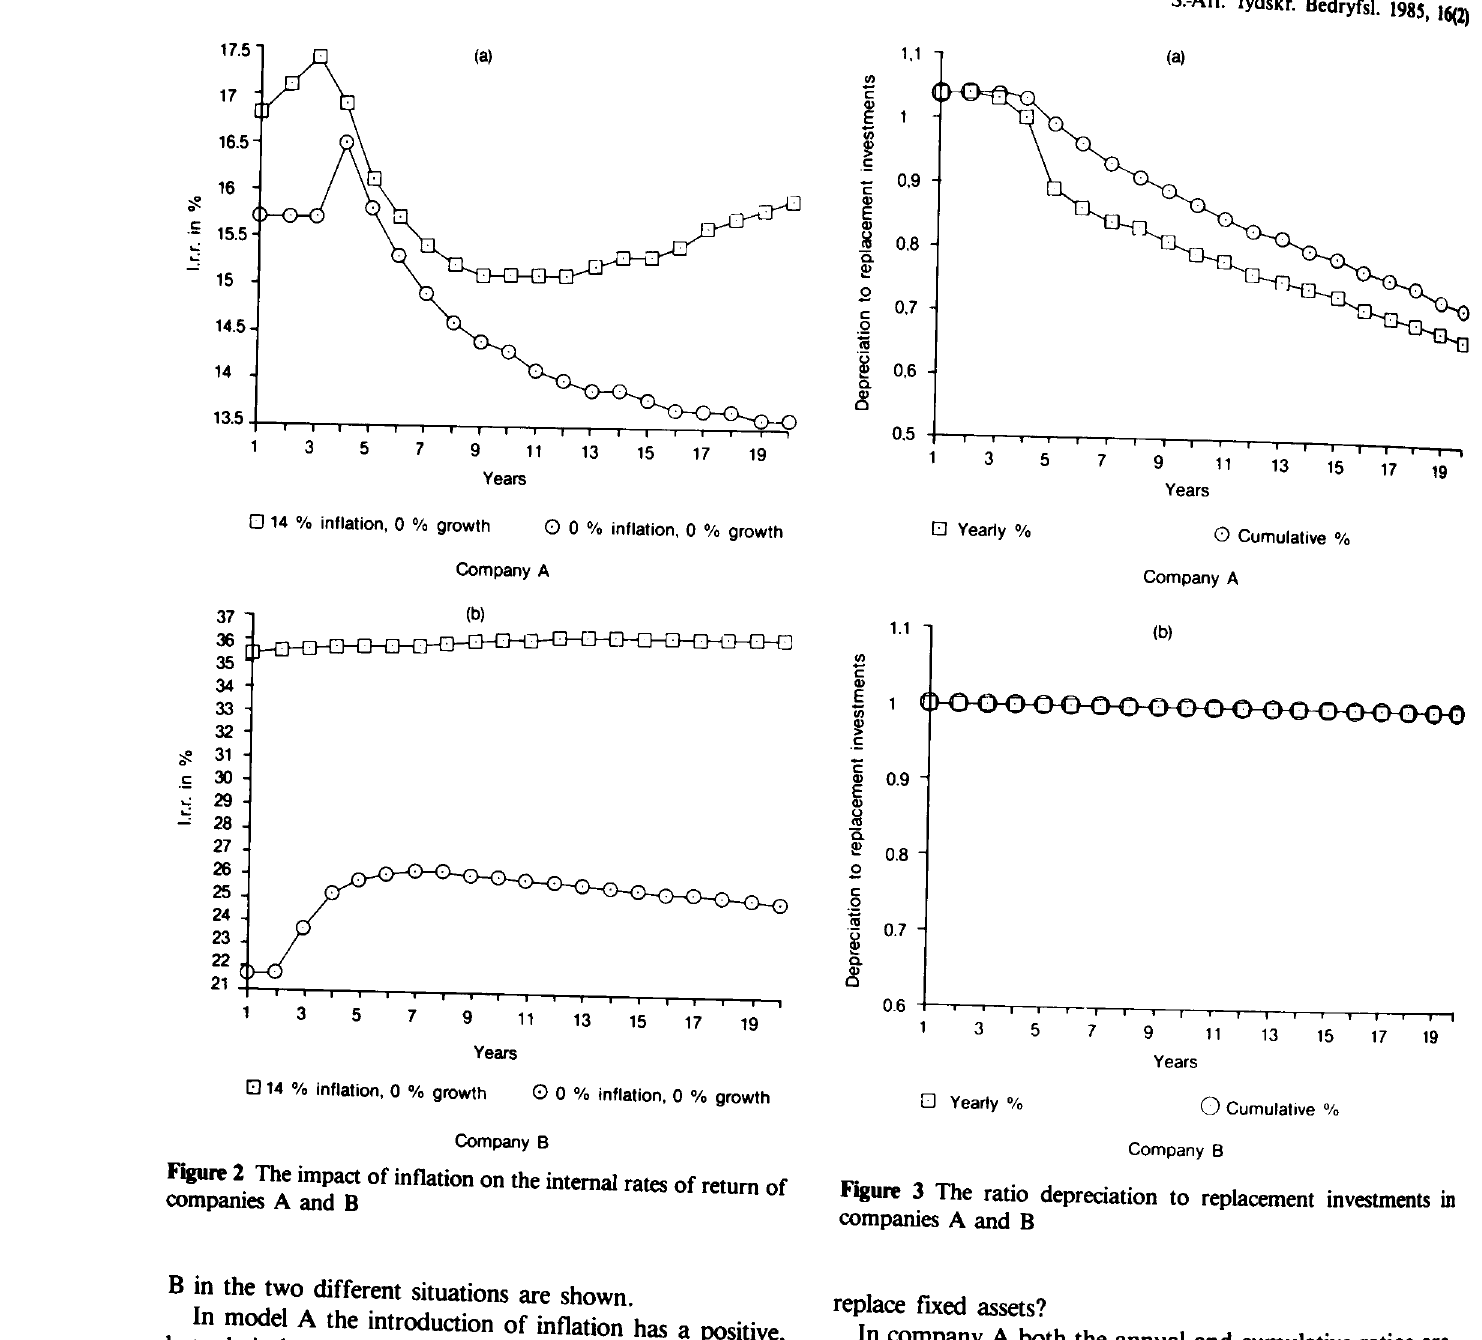
Figure 3 The ratio depreciation to replacement investments in companies A and B replace fixed